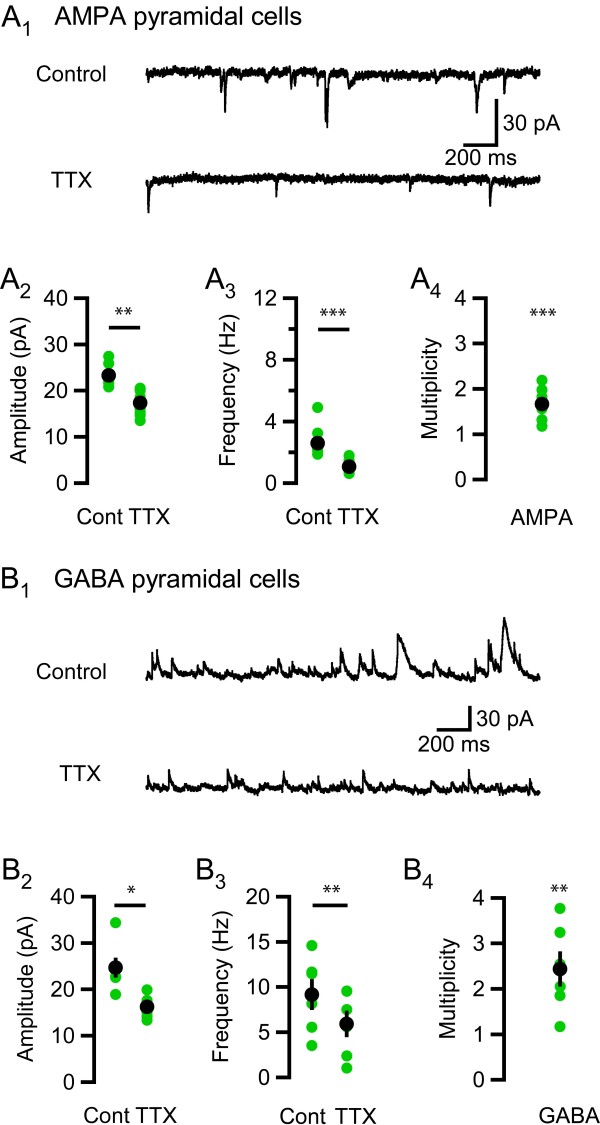
Multiple connections between CA3 and CA1 pyramidal cells and GABAergic cells and CA1 pyramidal cells in young adult rats. (A1) A typical recording at -80 mV from a pyramidal cell, upper trace shows AMPA sEPSCs under control conditions and lower trace shows mEPSCs after wash-in of TTX. (A2) TTX reduces the AMPA EPSC amplitude by 5.9 ± 0.8 pA (P = 0.004, n = 8, two-tailed paired t-test). (A3) TTX reduces AMPA EPSC frequency by 1.5 ± 0.4 Hz (P < 0.001, n = 8, one-tailed paired t-test). (A4) The average multiplicity was 1.7 ± 0.1 (P < 0.001, n = 8, one-tailed one-sample t-test with test value = 1). (B1) A typical recording at 0 mV from a pyramidal cell, upper trace shows GABA sIPSCs under control conditions and lower trace shows mIPSCs after wash-in of TTX. (B2) TTX reduces the GABA IPSC amplitude by 8.4 ± 2.7 pA (P = 0.03, n = 6, two-tailed paired t-test). (B3) TTX reduces GABA IPSC frequency by 3.2 ± 0.8 Hz (P = 0.005, n = 6, one-tailed paired t-test). (B4) The average multiplicity was 2.4 ± 0.4 (P = 0.007, n = 6, one-tailed one-sample t-test with test value = 1). Black filled circles show mean ± SEM and green filled circles show data from individual experiments. Asterisks denote the level of significance as follows: *: P < 0.05, **: P < 0.01, ***: P < 0.001.